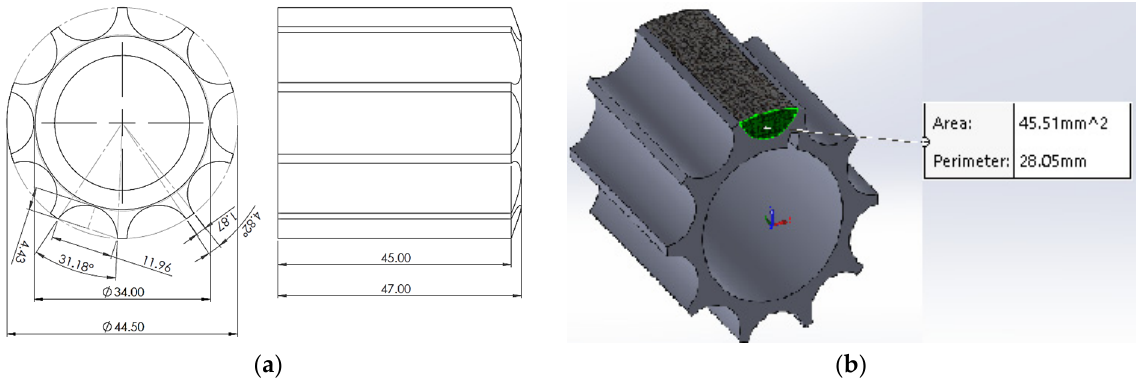
Figure 4. Fertilizer doser’s ten-groove roller: ( a ) parameters of doser; ( b ) cross-section of groove.